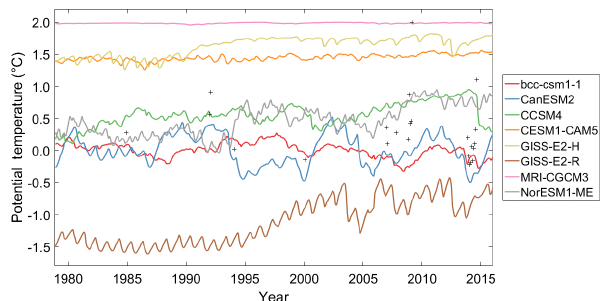
Figure 1. Monthly mean ocean potential temperature in the ASE averaged over 400–700m depth range, produced by a subset of CMIP5 AOGCMs over the period from 1979 to 2016, where the period from 2006 to 2016 is made up of projections forced with RCP8.5. Black + symbols show observed ocean potential temper- ature in the ASE from the Hadley Centre dataset, averaged over 400–700m depths during the same period.